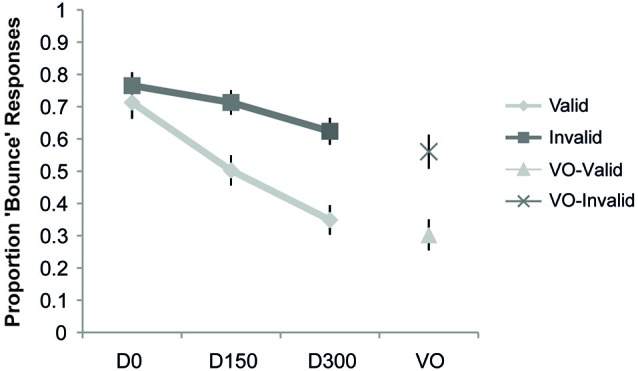
Results of Experiment 1. The proportion “bounce” responses are plotted as a function of condition. The respective points represent when there was no auditory stimulus (Visual Only, VO), and when the auditory stimulus occurred simultaneously with the visual intersection (D0), delayed by 150 ms from the visual intersection (D150), and delayed by 300 ms from the visual intersection (D300), separately for the validly and invalidly cued trial types. Compared to the validly cued trials, a significant increase in the bouncing percept was observed in the invalid trials for the VO, 150, and 300 conditions, thus indicating a narrowing of the TWI with attention. Error bars represent the standard error of the mean (SEM).